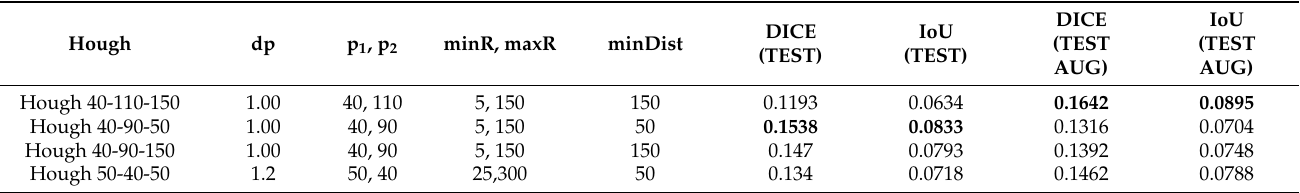
Table 6. Hough transform DICE and IoU scores on TEST and TEST AUG sets for different parameters combinations, where p stands for parameter, minR for min radius and maxR for max radius. Best results are bold.